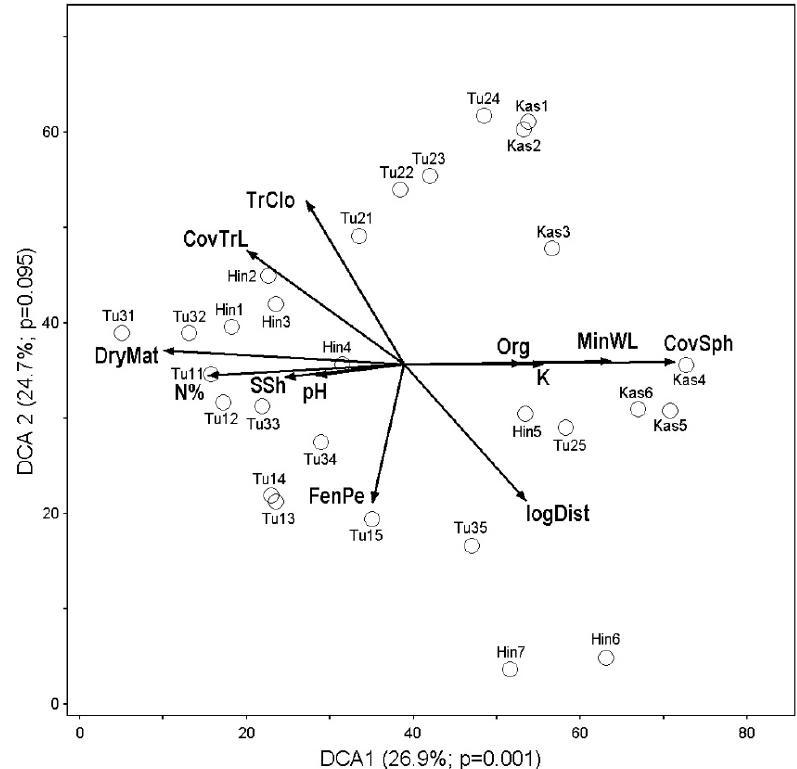
Figure 3. DCA biplot of sampling areas, main variables determining the vegetation structure and environmental conditions. Abbreviations: DryMat = content of dry matter in peat; CovTrL = tree layer cover from LIDAR data; TrClo = canopy closure of tree layer; Org = content of C (organic matter) in soil; K = content of total-K in soil; MinWL = minimum water level; CovSph = total cover of Sphagnum species; logDist = log-transformed distance from cutoff ditch; FenPe = thickness of fen peat; pH = peat water pH; SSh = number of shrub layer species; N% = total-N content of soil. For the Tuhu (Tu1, Tu2) and Tuudi (Tu3) mires, the first number indicates the transect number, and the second number the sampling area starting from the cutoff ditch; for the other mires – Hindaste (Hin) and Kassissare (Kas) only the sampling area number is